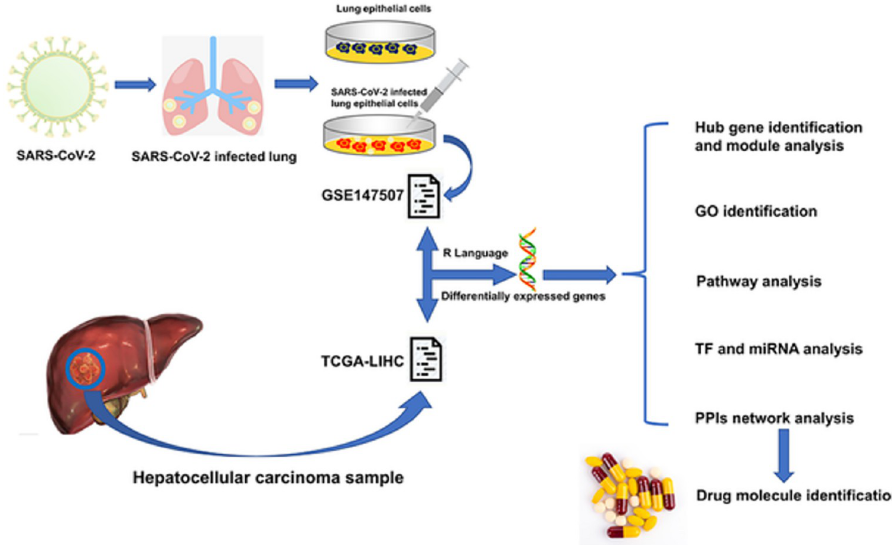
Fig 1. Fundamental workflow for the current study. Two types of samples (Lung epithelial cells, SARS-CoV-2 infected lung epithelial cells) were collected from SARS-CoV-2 infected lung epithelial cells and both are included in the GSE147507 dataset. GSE147507 dataset contains a sample of SARS-CoV-2 infected lung epithelial cells and the TCGA-LIHC dataset contains hepatocellular carcinoma samples. R programming language was used to identify the Common DEGs from both datasets. From the common DEGs, GO identification, KEGG pathway, PPIs network, TF and miRNA analysis, hub gene identification and module analysis were designed and based on those analysis drug molecule identification was